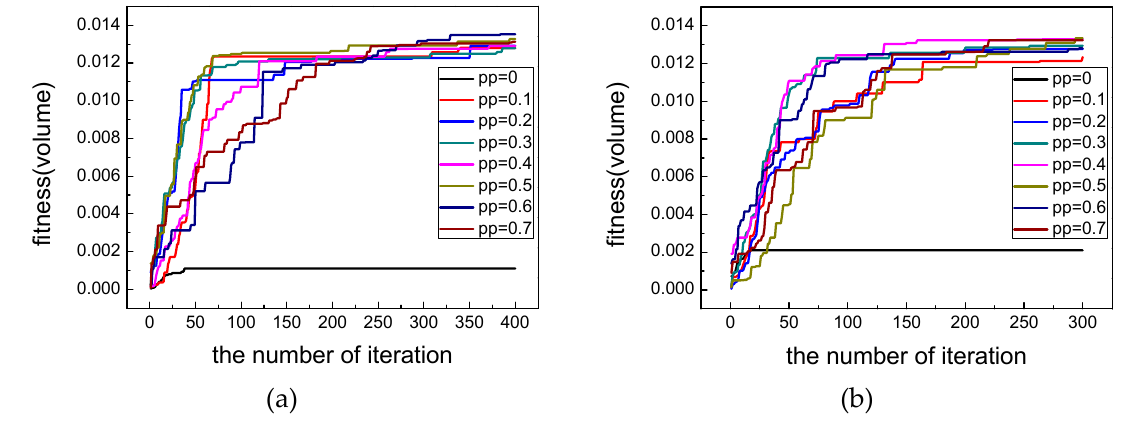
Figure 4. Parameter analysis: ( a ) 20 particles and 400 iterations; ( b ) 30 particles and 300 iterations.